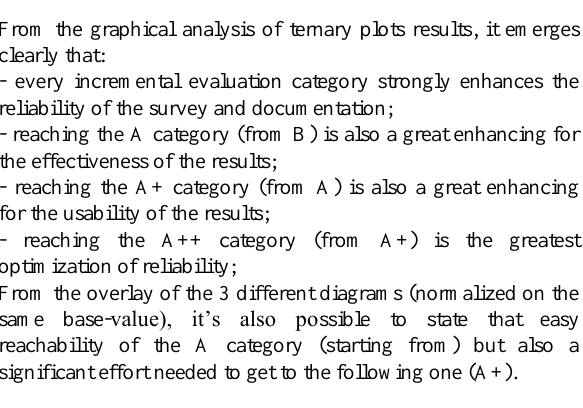
Figure 5. Data aggregation for the assessment of evaluation